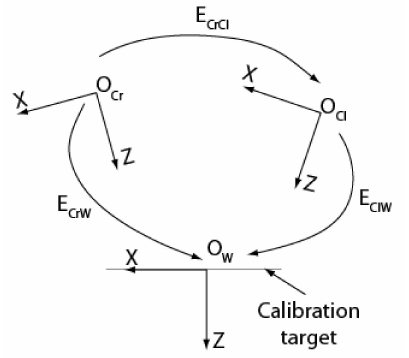
Figure 8. General principle for calibrating a standard stereo